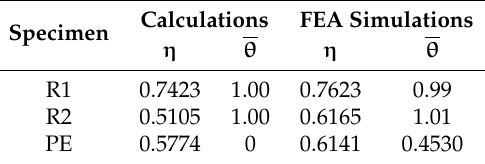
Table 4. A comparison of the stress states between the calculations and the finite element analysis (FEA) simulations.